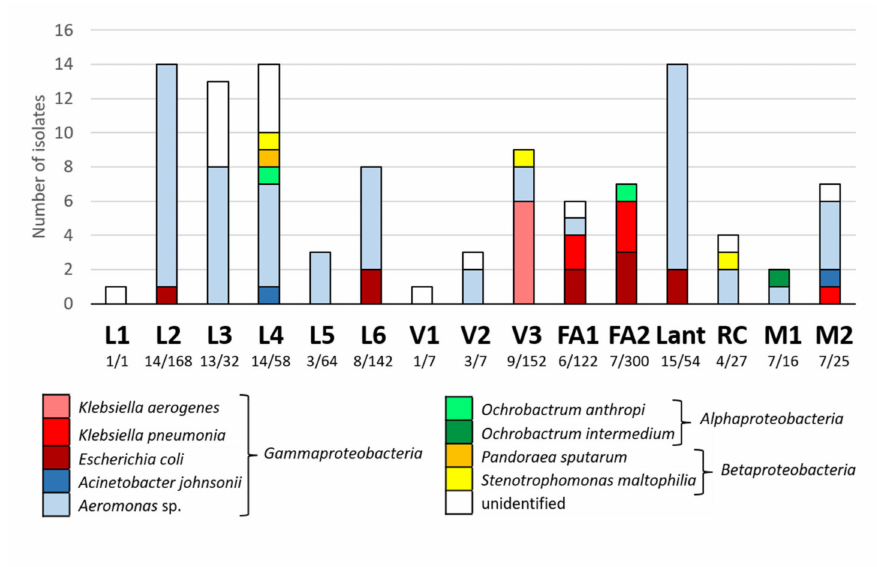
Figure 6. Identification of strains isolated on multi-ATB medium during C2 campaign. Number of strains selected for identification and total number of strains enumerate on multi-ATB media are indicated under sampling site name. L1 to L6: Lez River; V1 to V3: Verdanson River; FA1 and FA2: Font d’Aurelle River; Lant: Lantissargues River; RC: Rieu Coulon River; M1 and M2: Mosson